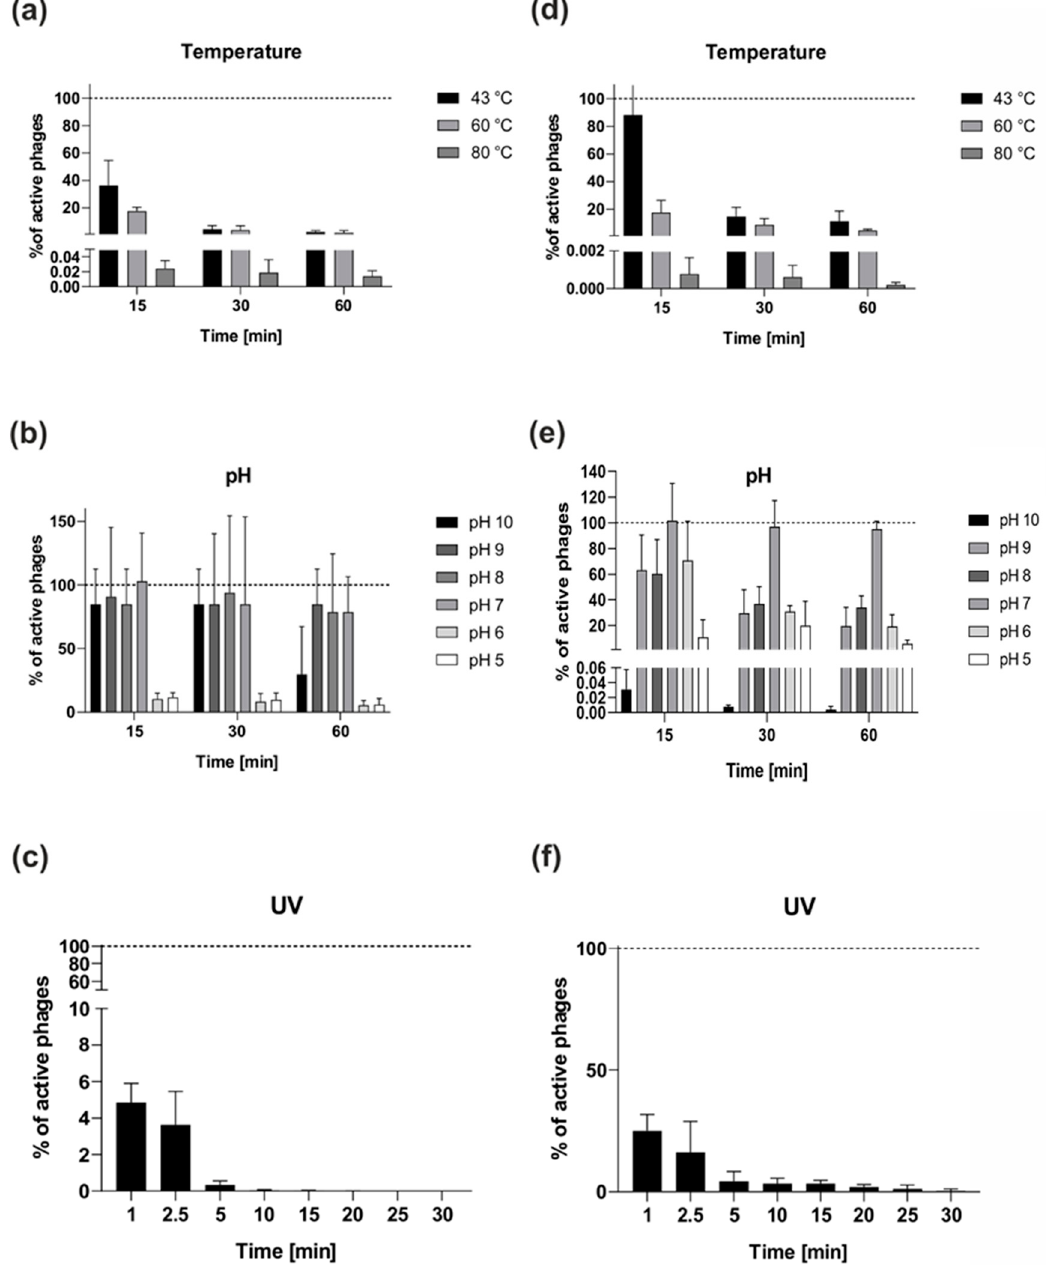
Figure 6. Stability of the vB_OspM_OC (left column) and vB_OspP_OH (right column) phages at various temperatures ( a and d , respectively), pH ( b and e , respectively) , and UV light ( c and f , respectively). The presented results are the average values from three experiments, with standard deviation represented by the error